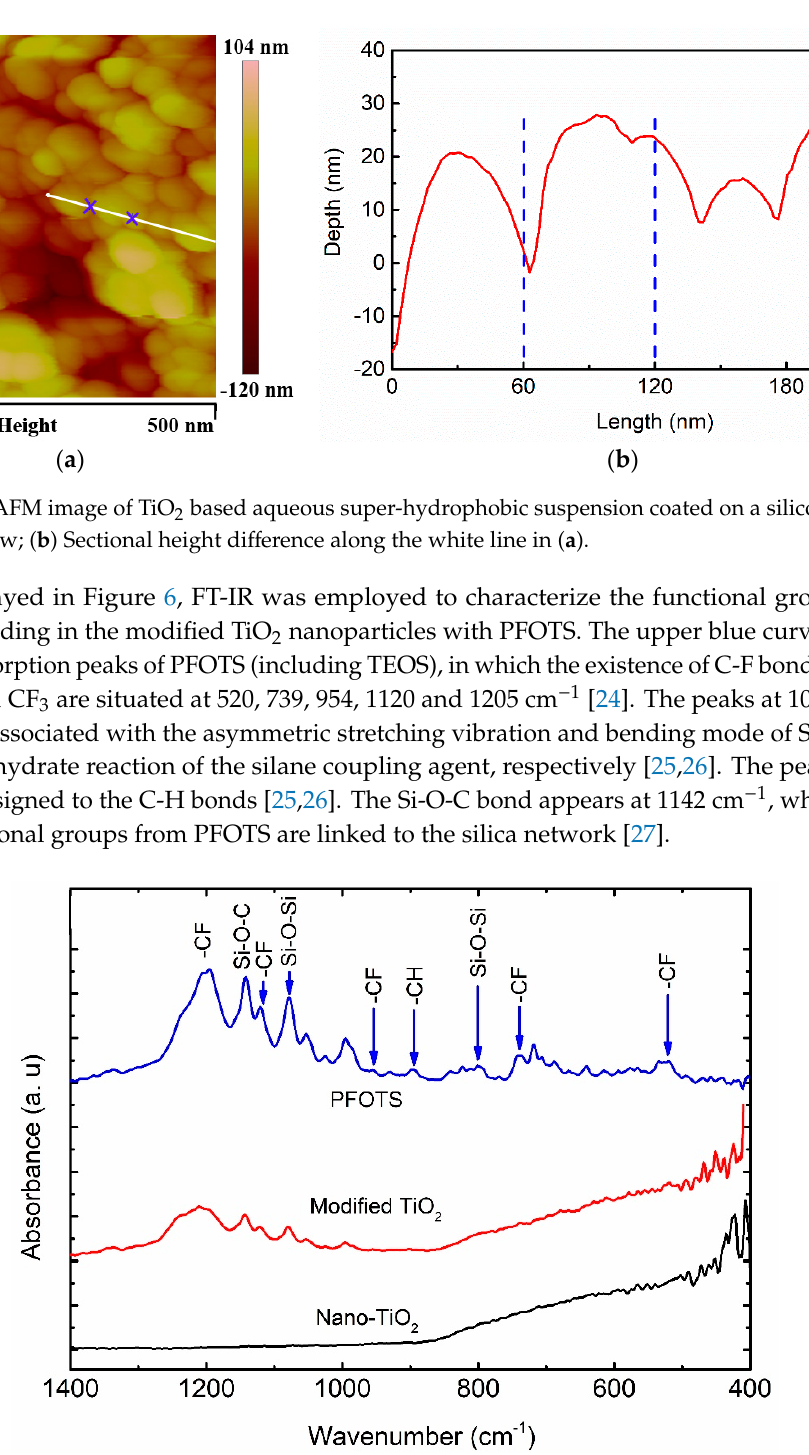
Figure 6. FT-IR spectra of the PFOTS modified nano-TiO 2 particles.